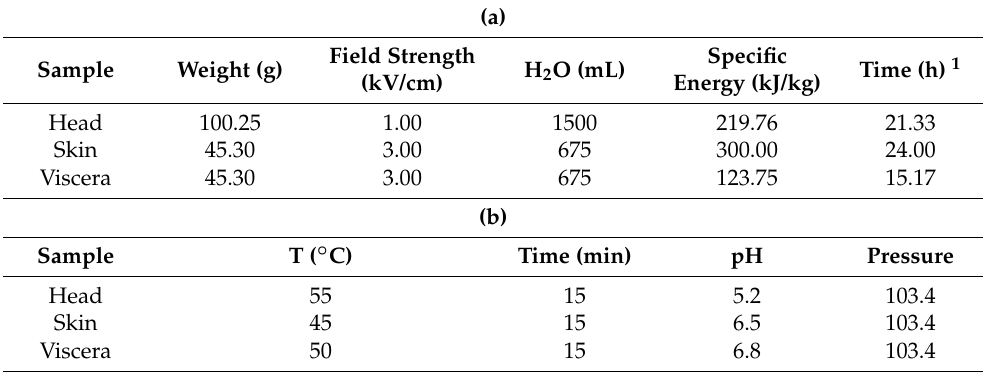
Table 1. ( a ) Pulsed electric fields (PEF)-assisted extraction experimental conditions, ( b ) Accelerated solvent extraction (ASE) experimental